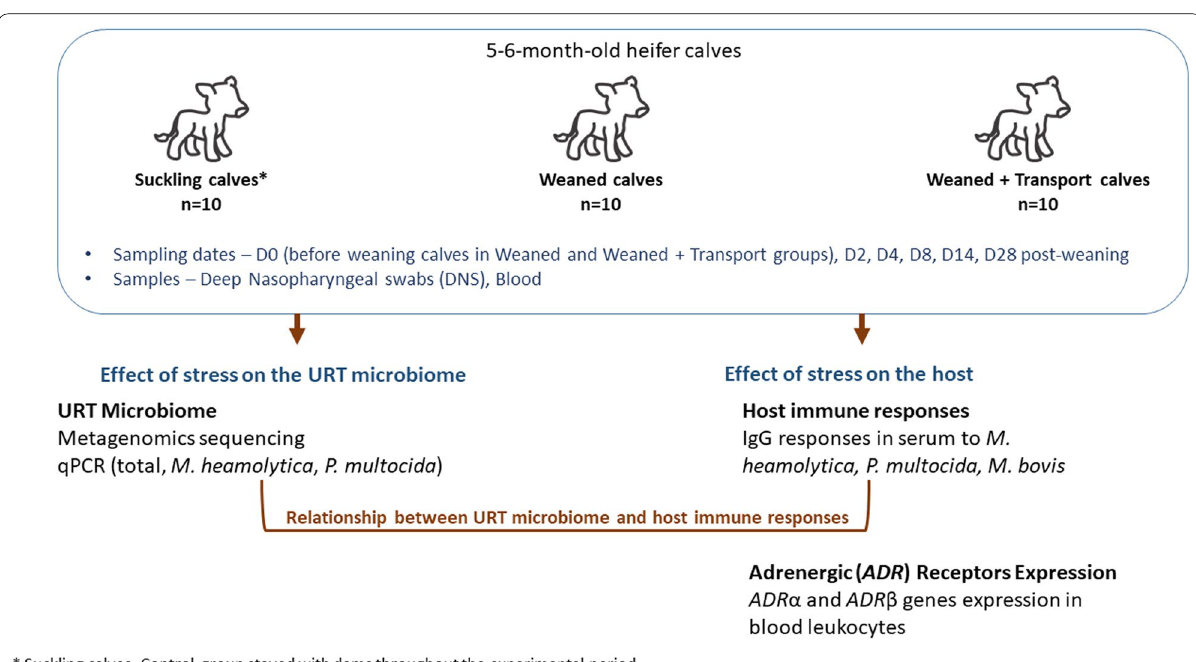
Fig. 6 Flow chart depicting sampling process and approaches used to study the URT microbiome and host immune responses during weaning and transportation stress in beef